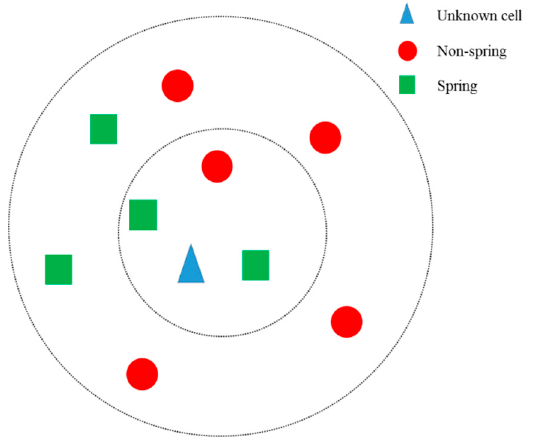
Figure 7. Schematic of classification procedure in the k-nearest neighbors algorithm.